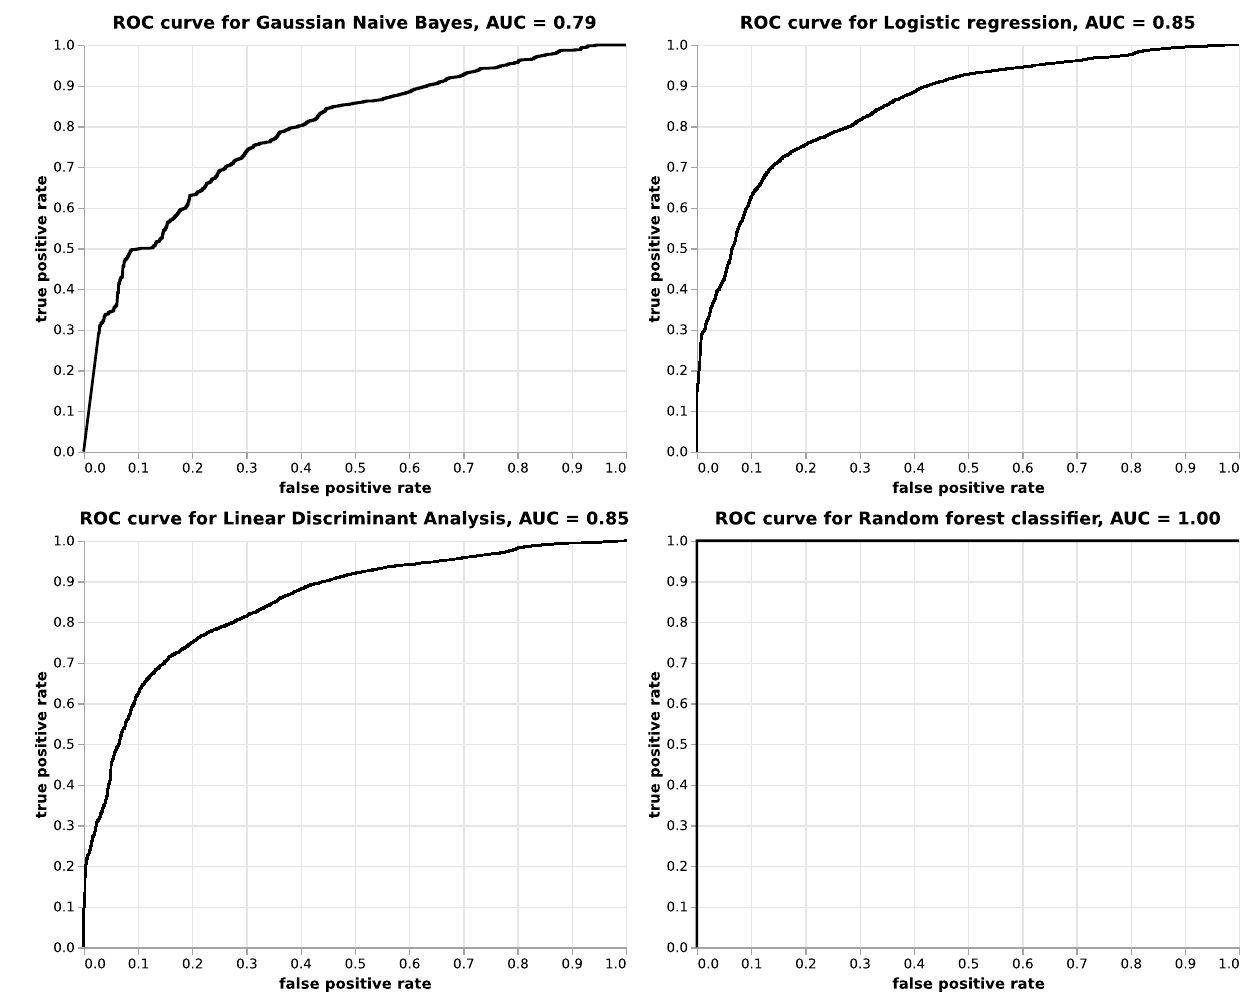
Figure 5. ROC curve for each classifier applied to the secondary data. The x-axis and the y-axis correspond to the FP and TP rates, respectively. The black line represents the ROC curve. The area under the curve represents the AUC which is reported textually above the graph. Each curve depicts the true positive rate or the recall on the y-axis and the false positive rate or the Type I error on the x-axis. The latter corresponds to the ratio of mushrooms wrongly classified as poisonous to all edible